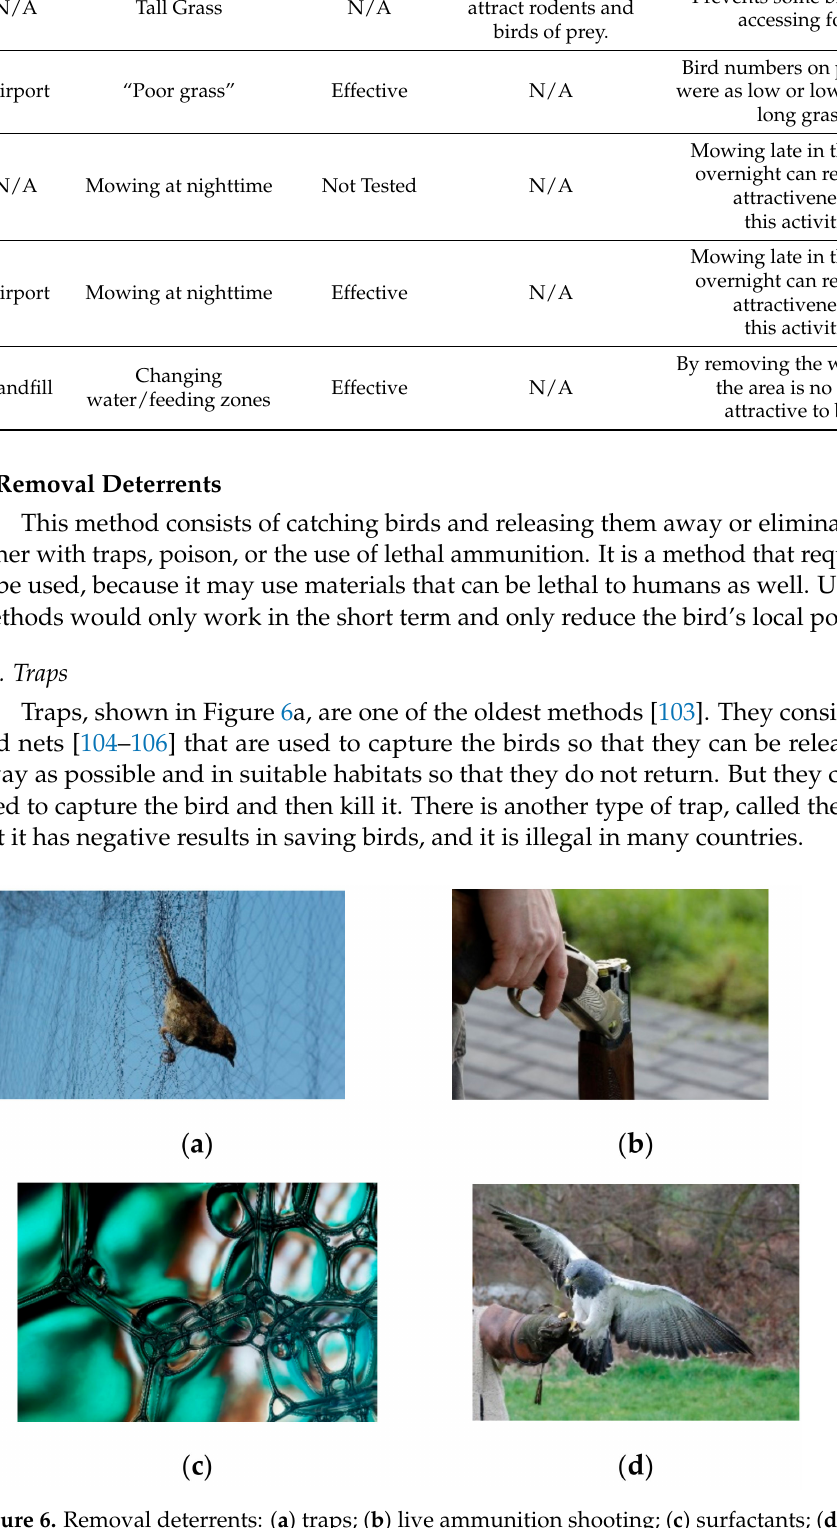
Figure 6. Removal deterrents: ( a ) traps; ( b ) live ammunition shooting; ( c ) surfactants; ( d )